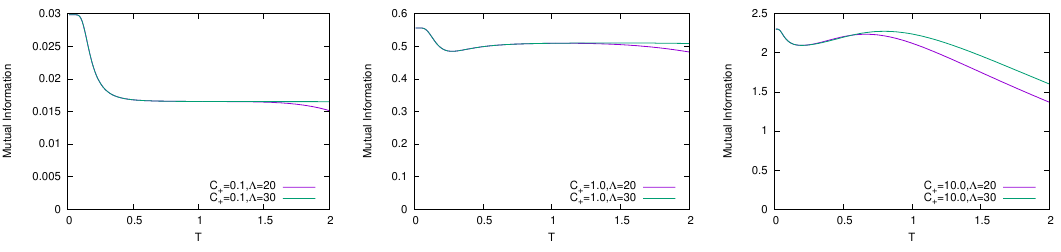
of MI at low temperature reflects the decay of the quantum entanglement. In order to study the quantum correlation more clearly, we need to subtract the classical